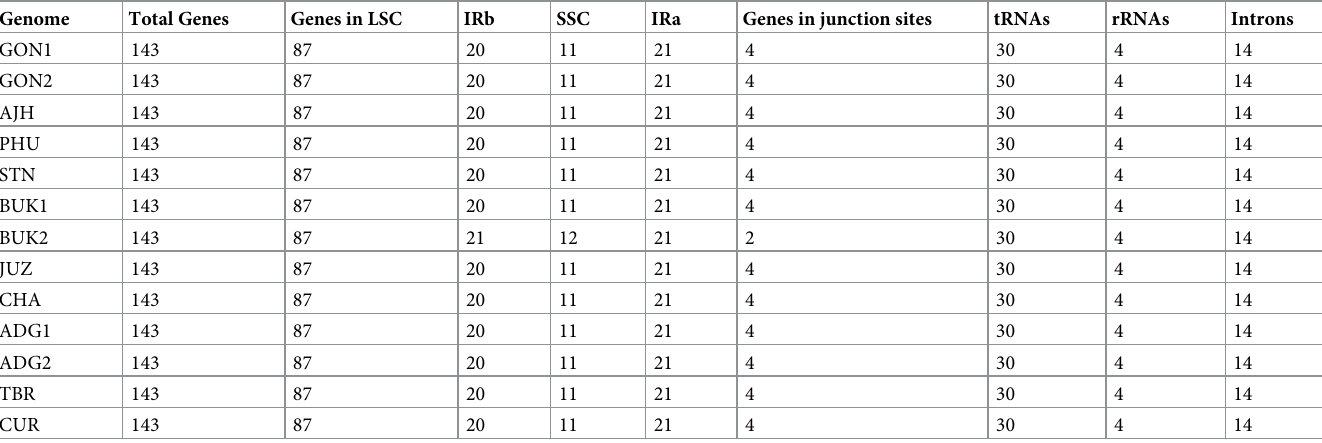
Table 3. Distribution of genes in the plastomes.